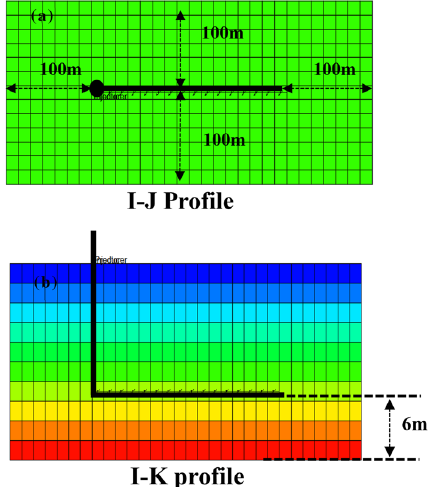
Fig. 2 The permeability distribution pattern along the horizontal